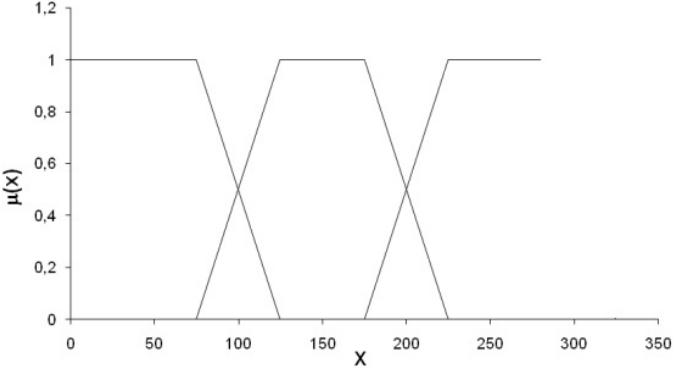
Figure 5. An example of membership